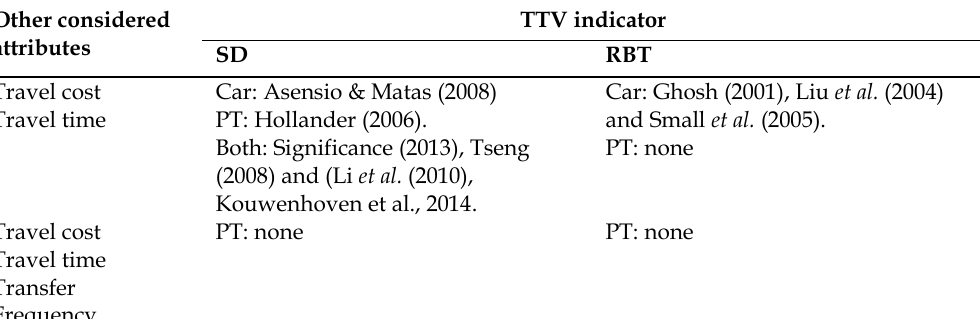
Table 1. Attributes used in the literature on travel time